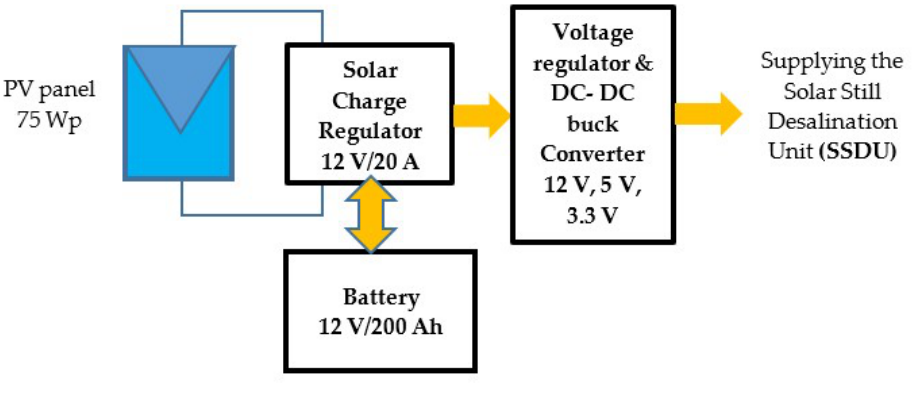
Figure 6. Supplying the SSDU using a PV system.